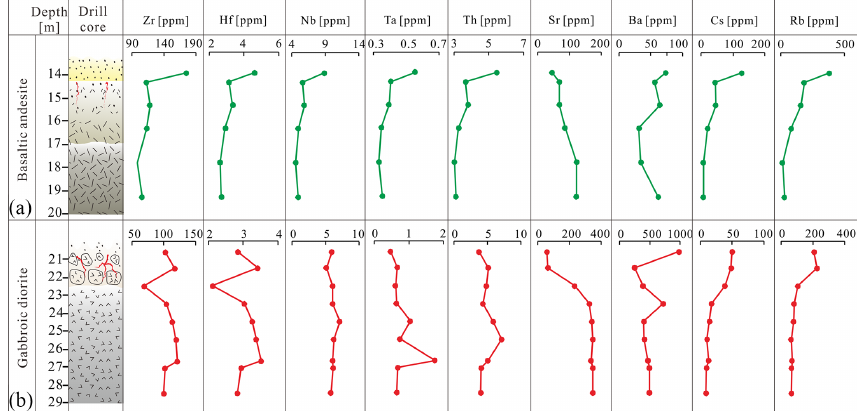
Figure 6. Representative trace element content (in ppm) of basaltic andesite (a) and gabbroic diorite (b) along the drill core profile.